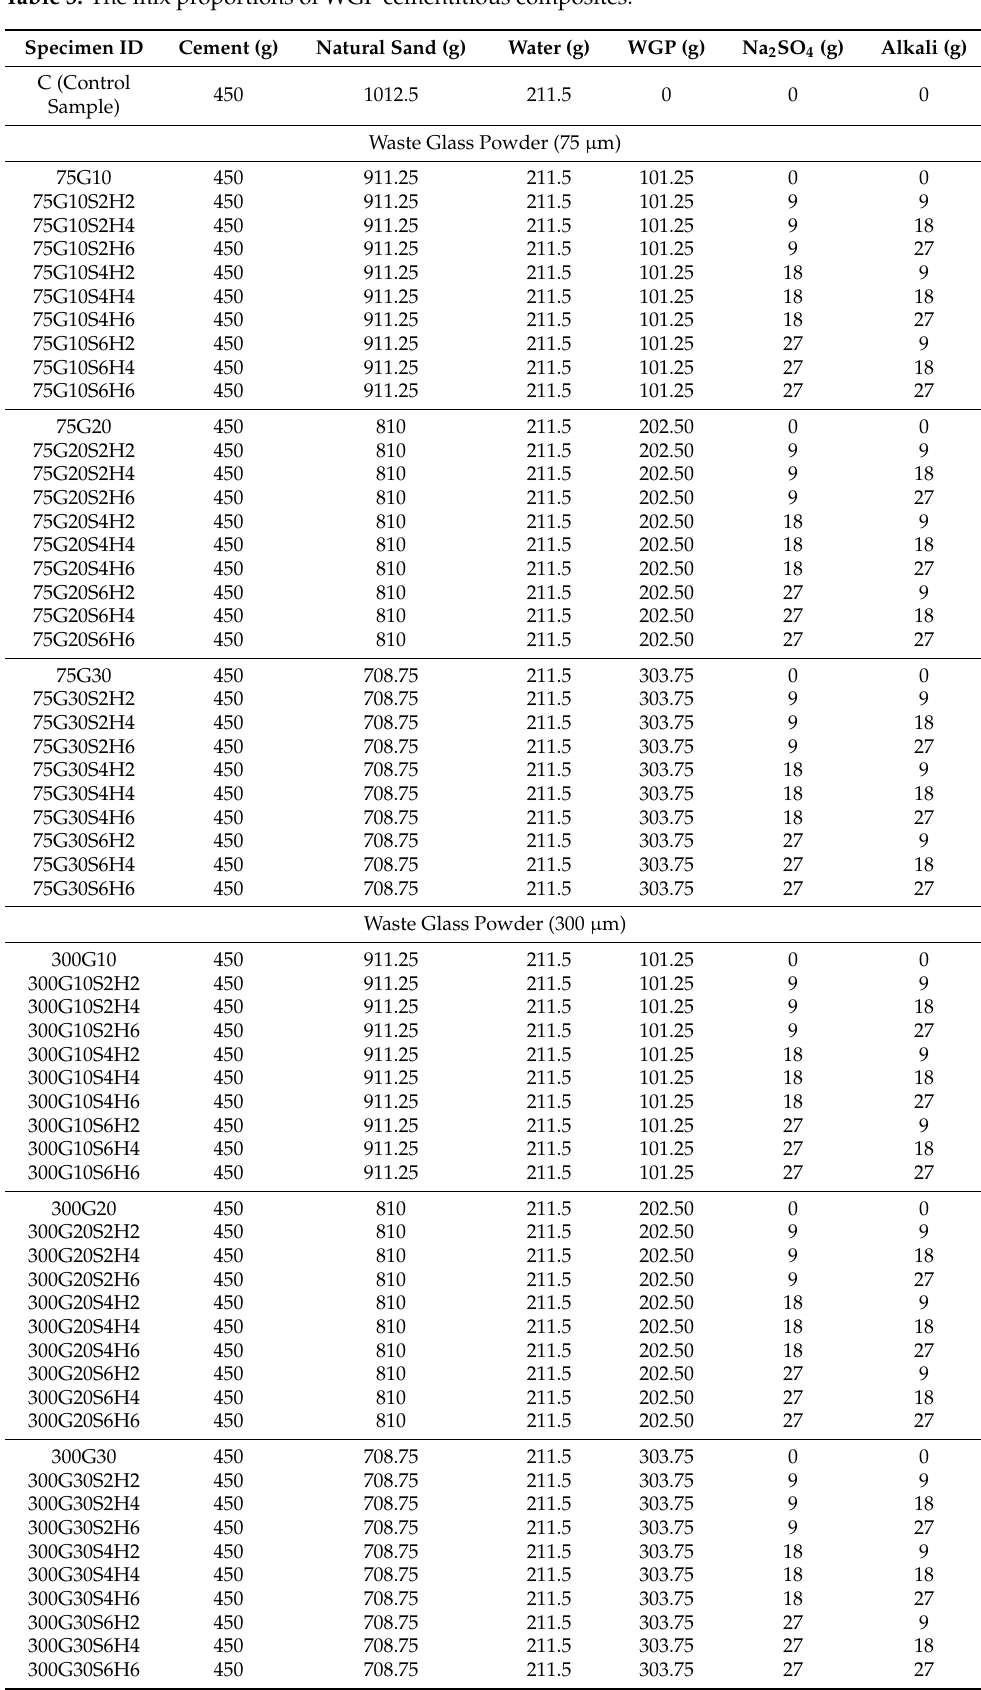
Table 3. The mix proportions of WGP cementitious